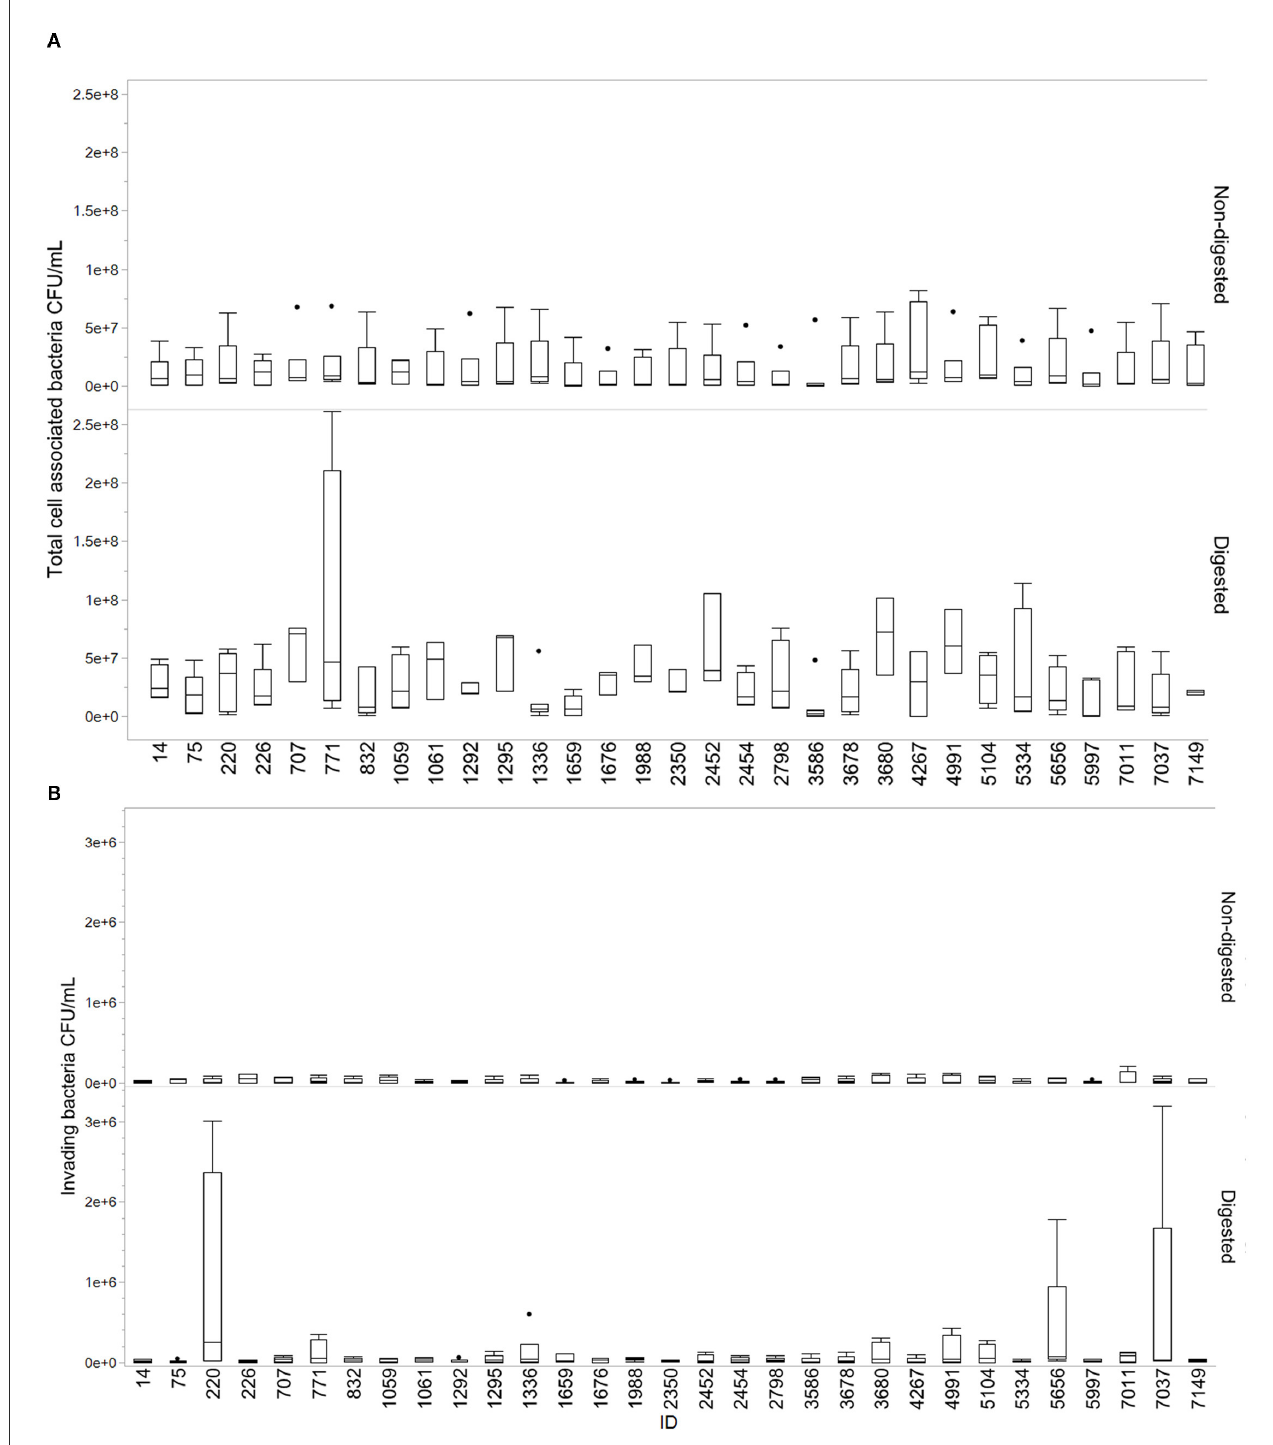
FIGURE3 Total cell-associated bacteria and invading bacteria for digested and non-digested. Boxes represent the quartiles and the median value, with included confidence intervals indicated by whiskers. Values are given in number of CFU/mL. The dots represent outliers in the data. (A) Total cell-associated bacteria in Q18 CFU/mL for digested and non-digested. (B) Number of invading bacteria in CFU/mL for digested and non-digested.